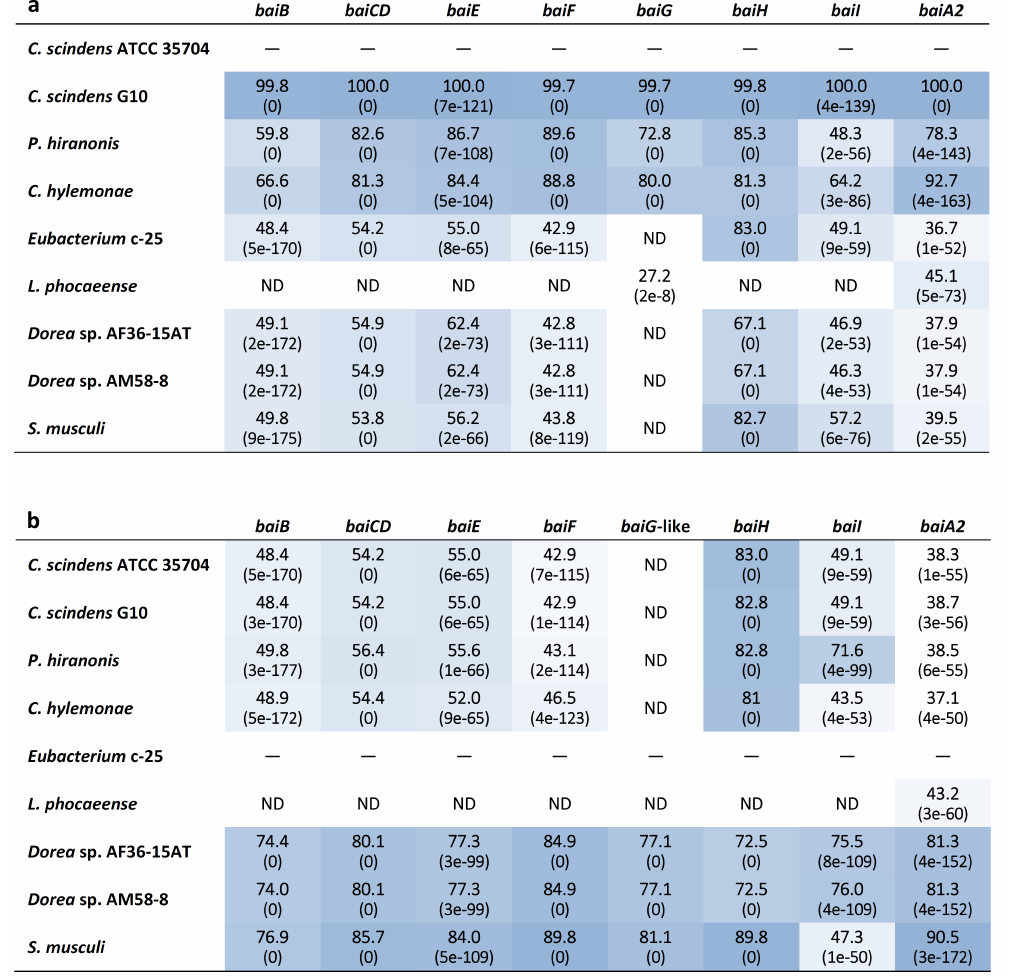
Figure 6. Heatmap table of bai gene amino acid sequence identity among known and newly-identified, hypothesized DCA producers. The closest phylogenetic relative of c-25, L. phocaeense , was also included. The amino acid sequence identity (%) was evaluated by BLASTp analysis using ( a ) C. scindens ATCC 35704 T and ( b ) Eubacterium sp. c-25 reference bai genes as queries. BLAST Expect values (E-values) are given in parentheses. Darker boxes indicate higher degrees of sequence identity. ND = Not detected. See Table S1 for bai gene identifier